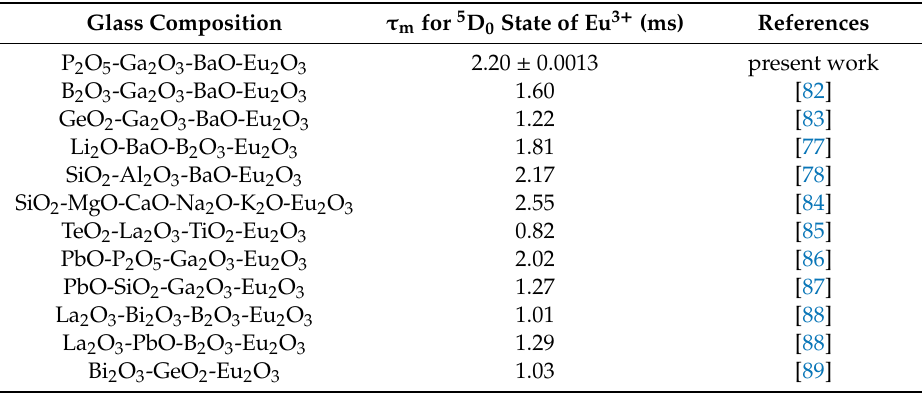
Table 4. Comparison of luminescence lifetime for 5 D 0 state (Eu 3 + ) of inorganic glasses. Glass